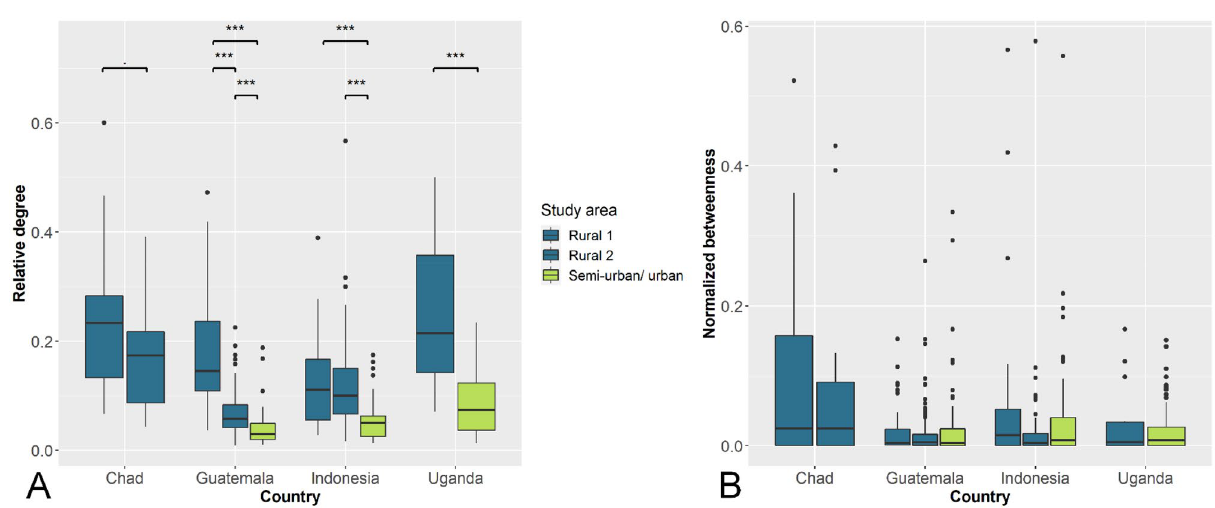
Figure 2. ( A ) Relative degree and ( B ) normalized betweenness distributions of ten dog contact networks in Chad, Guatemala, Indonesia and Uganda. Significance codes: 0.001 = ***, 0.01 = **, 0.05 = *, 0.1 =